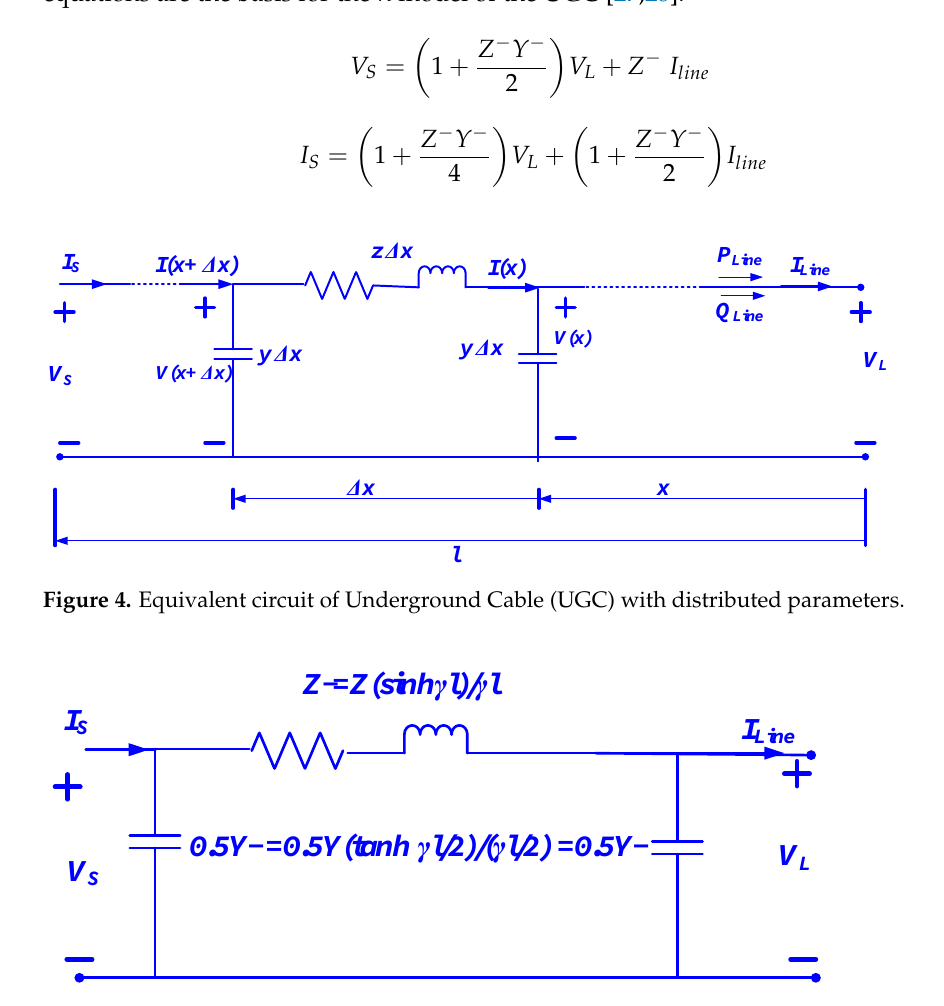
Figure 4. Equivalent circuit of Underground Cable (UGC) with distributed parameters.